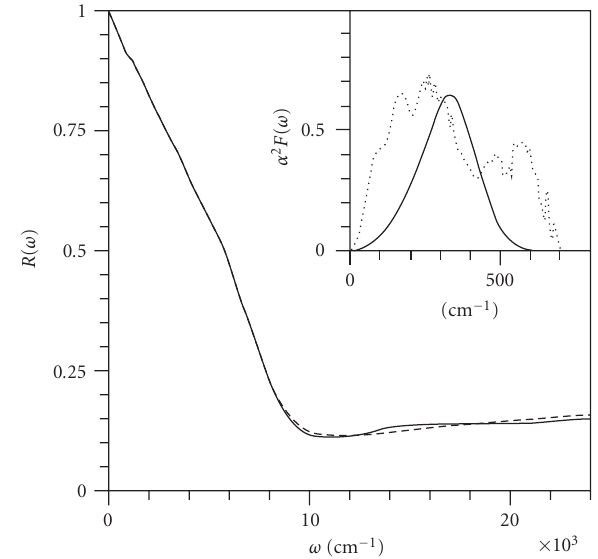
Figure 8: Experimental (solid line) and calculated (dashed line) data of R ( ω ) in optimally doped BSCO [106] at T = 100K. Inset: ( ω ) F ( ω )—solid line. The phonon density of the reconstructed α 2 tr states F ( ω )—dotted line. From